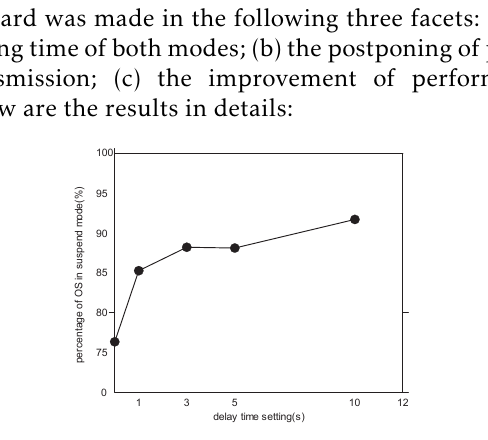
Figure 8. Percentage of OS spend in suspend